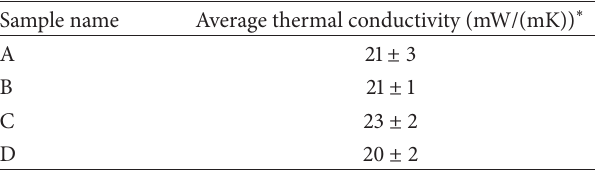
they do attach when the ratio is increased to 0.05. It indicates Table 2: Average thermal conductivity of the four samples created by various coating